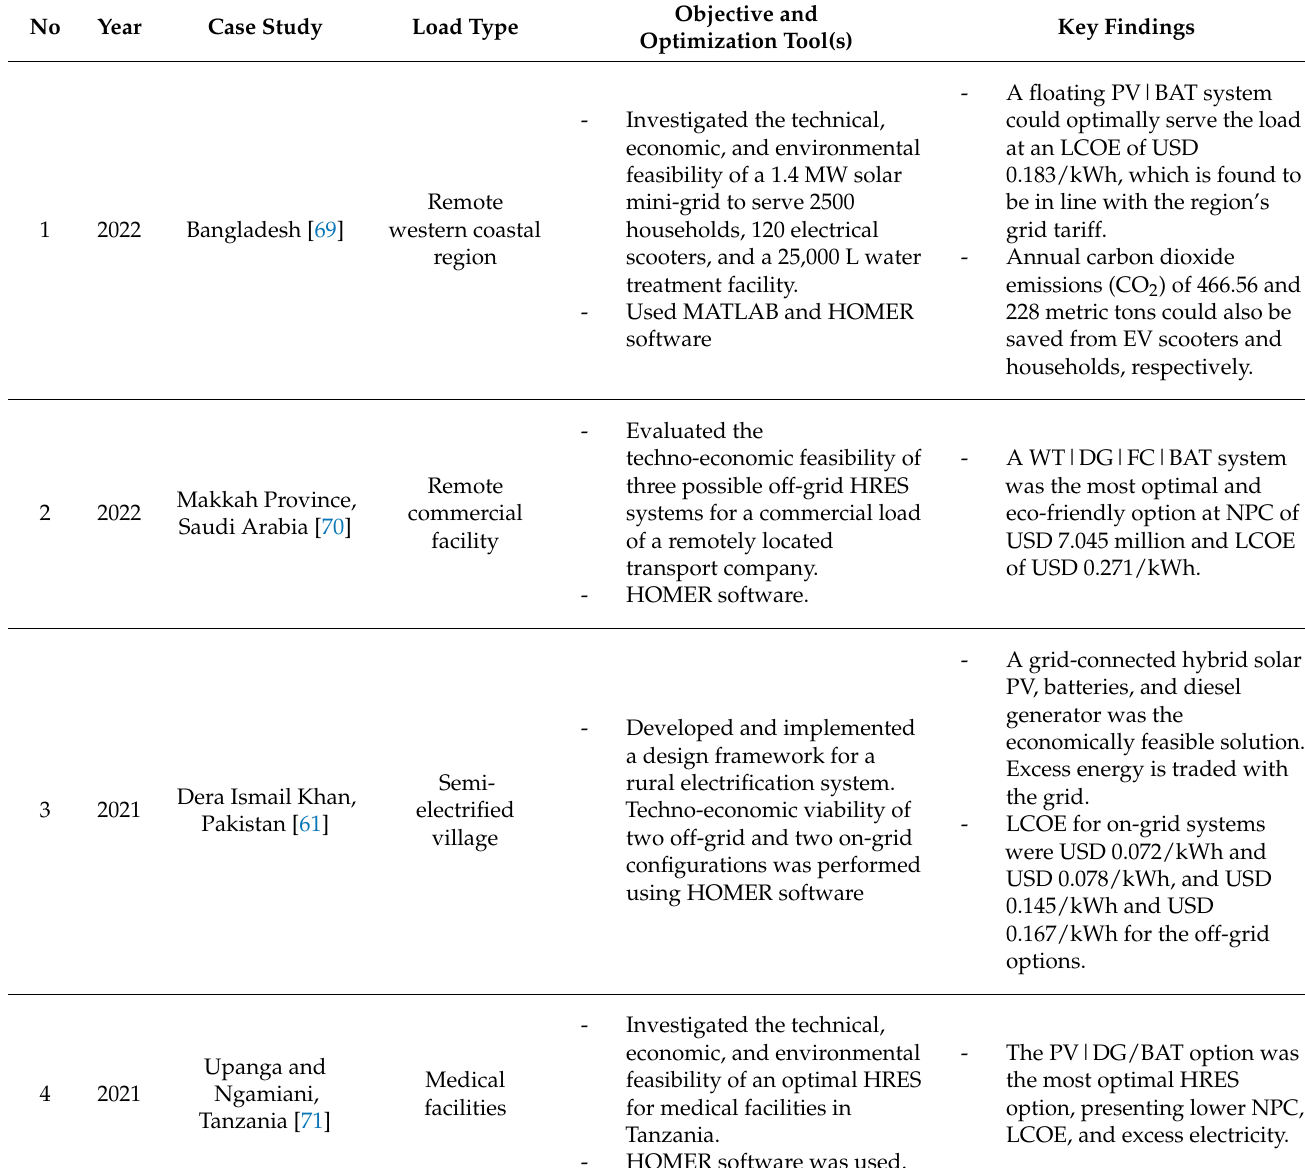
Table 2. Selected research on off-grid hybrid renewable energy systems (HRES), published between 2018 and 2022